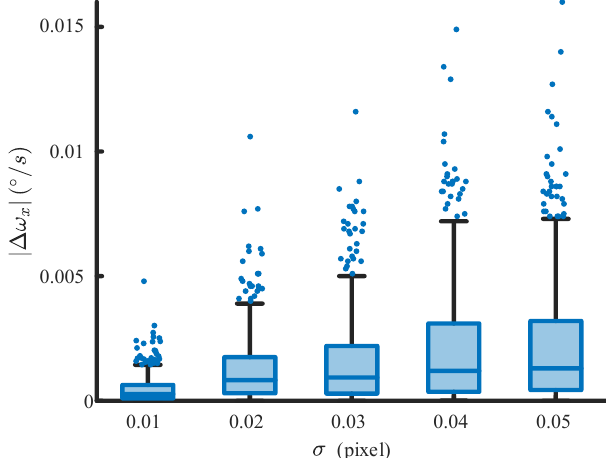
Figure 11. Absolute value of the angular velocity estimation error under different angular velocities: ( a ) the error when ω y is equal to zero, and ( b ) the error when ω x is equal to zero. In the actual measurement environment, the performance of a star tracker will be affected by detector noise. To test the robustness of the algorithm under different noise conditions, star images synthesized under different position noise were tested. The star images used in the noise test were synthesized when ω x were equal to 3 ◦ /s and when ω y was zero. Gaussian position noise was added during the synthesis of the star maps. The Gaussian noise was added to the star centroid in the process of star image generation. The mean of the noise was set to zero, and the variance σ was set from 0.01 pixels to 0.05 pixels. The number of experiments per variance is set to 500. The box chart of the absolute value of the angular velocity estimation error is shown in Figure 12. As the variance of position noise increases, the accuracy of angular velocity estimation decreases. The maximum value of outliers is also positively correlated with noise variance. When the position noise variance is less than 0.05 pixels, the fourth quartile of velocity estimation error is smaller than 0.01 ◦ /s.